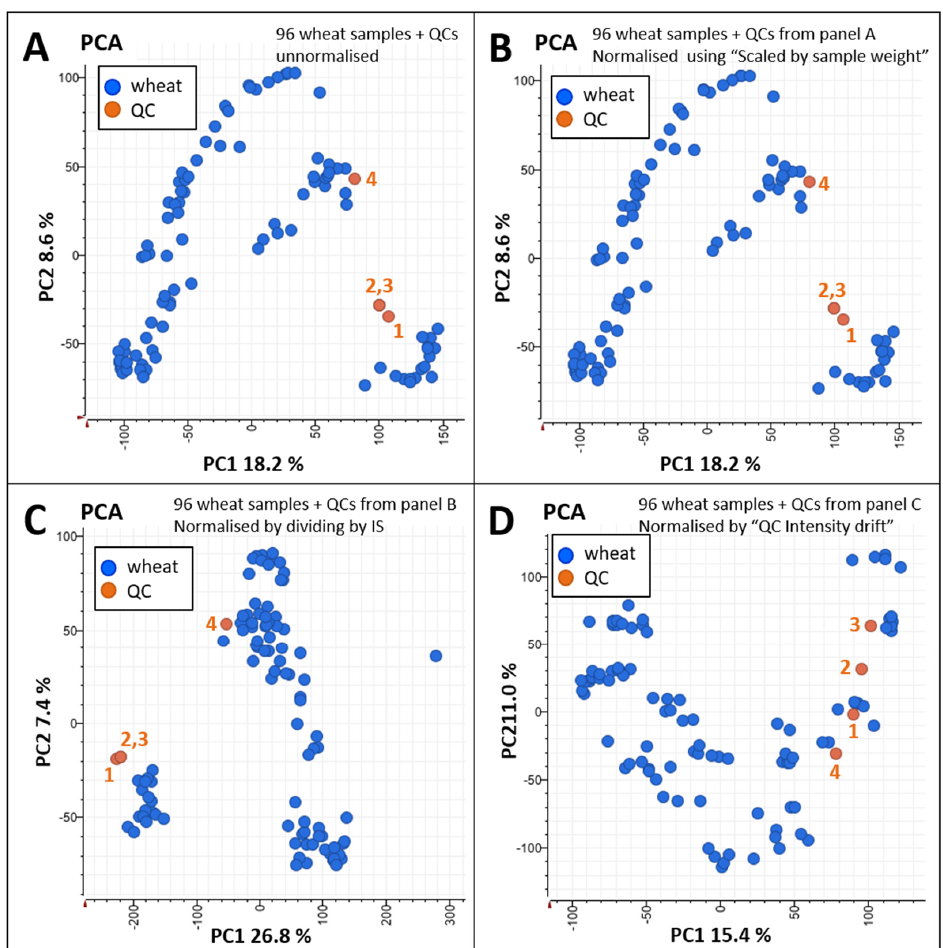
Figure 7. Principal component analysis (PCA) for method validation. Twenty milligrams (±0.2 mg) from 96 wheat cultivars was weighed, extracted using 0.5 mL Gnd-HCl buffer, and 10 µL extract aliquots were digested using trypsin/Lys-C. QCs and IS are described in the Materials and Methods. LC–MS data were acquired using LC method 6. ( A ) PC1 vs. PC2 plot based on unnormalised LC–MS quantitative data of the 96 wheat and QCs samples; ( B ) PC1 vs. PC2 plot based on LC–MS quantitative data from panel A normalised using the sample weights; ( C ) PC1 vs. PC2 plot based on LC–MS quantitative data from panel B normalised using the IS cluster; ( D ) PC1 vs. PC2 plot based on LC–MS quantitative data from panel C normalised using the injection order of the QCs (indicated with the orange numbers) and the ‘intensity drift’ algorithm of Genedata Analyst.